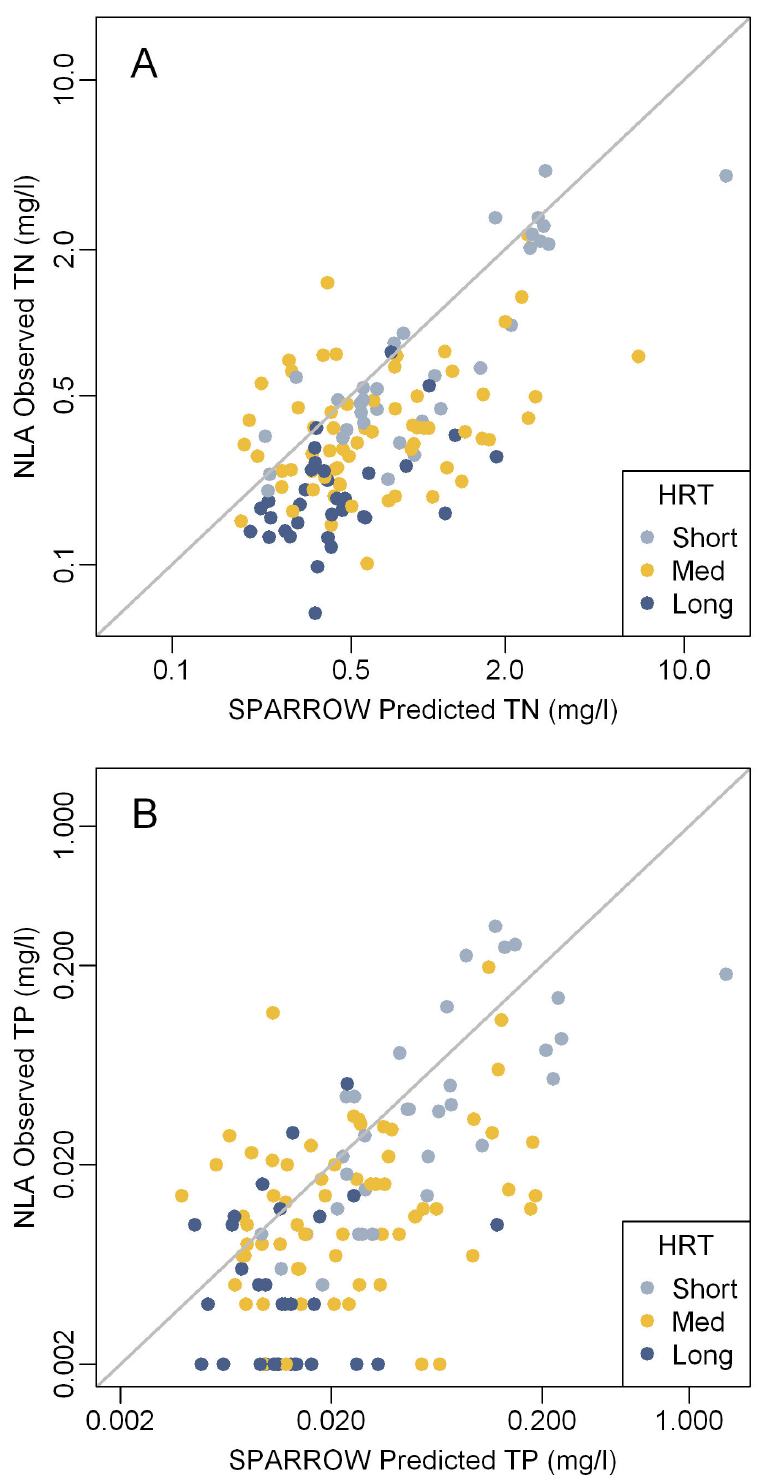
Figure 2. Total nitrogen (A) and phosphorus (B) in Northeast Lakes. National Lake Assessment 2007 observed summer concentrations versus the average annual SPARROW predicted concentrations. Observations are color coded by hydraulic residence time (HRT: Short < 0.04 years; Medium = 0.04 to 0.4 years; Long > 0.4 years). TN = Total Nitrogen. TP = Total Phosphorus. doi: 10.1371/journal.pone.0081457.g002 PLOS ONE |